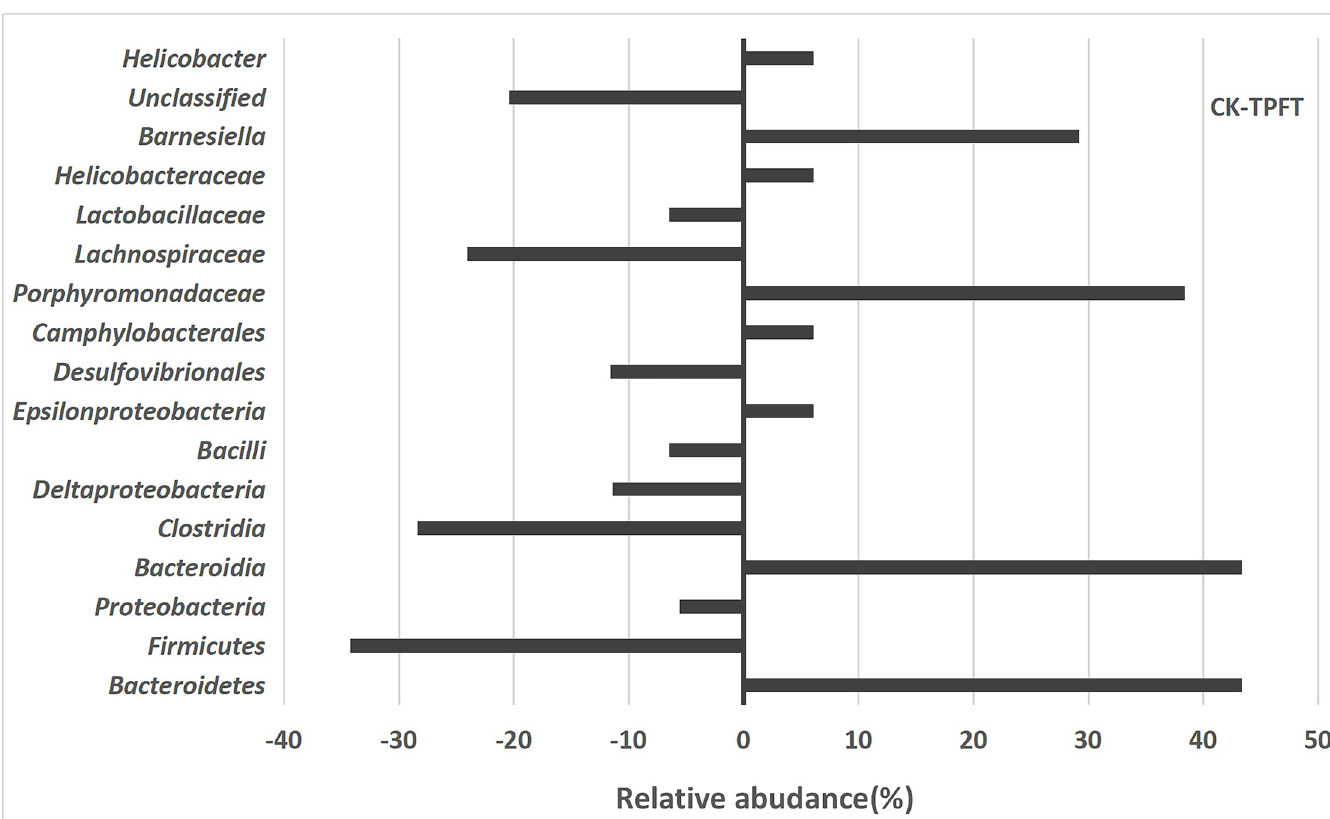
Fig 3. Effects of exclusive enteral nutrition (EEN)-n-3 polyunsaturated fatty acids (3PUFAs) on the gut microbiome (species level) after 8 weeks of treatment in mice compared with mice fed a regular diet. The bacteria were analyzed using the sequencing of the V4 region of the 16S ribosomal RNA. 3PUFAs-8 week: the experimental group treated with 3PUFAs for 8